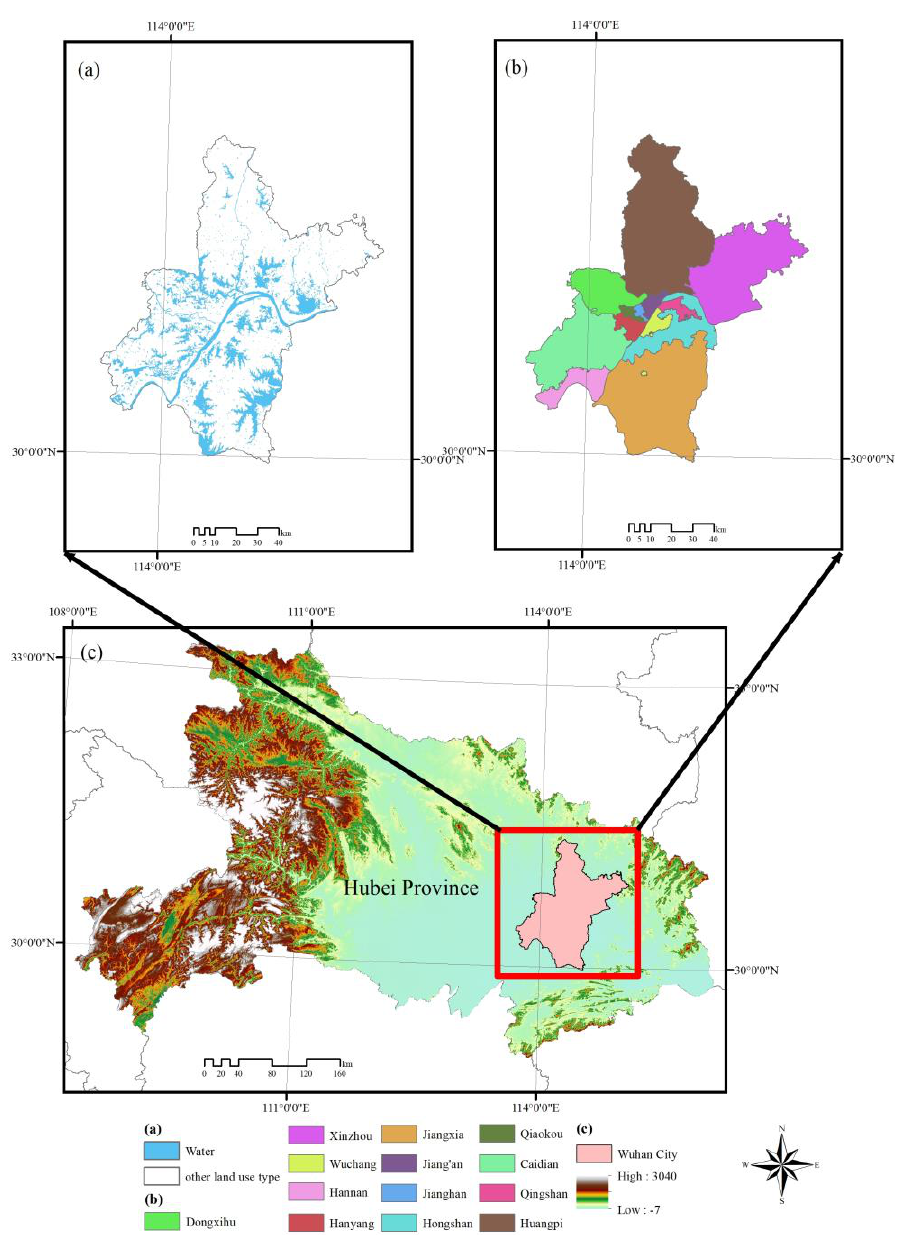
Figure 1. The location map of